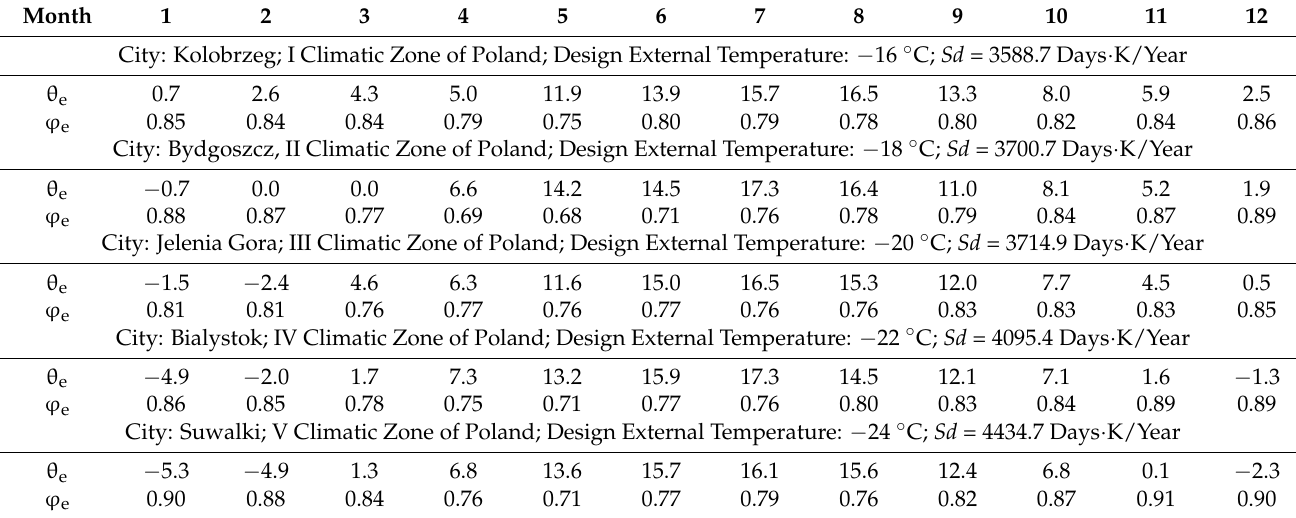
Table 3. Climatic data for five selected cities in Poland (own elaboration based on